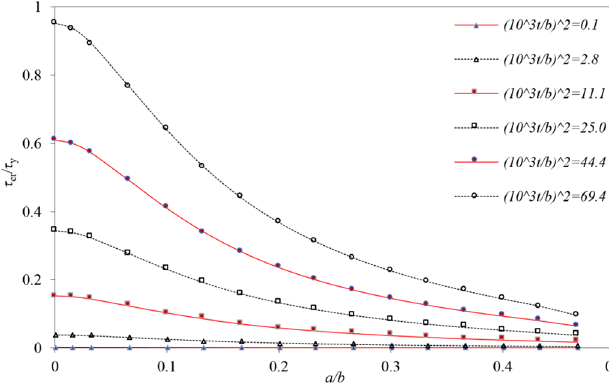
Fig. 8. Buckling of square plates with square holes.